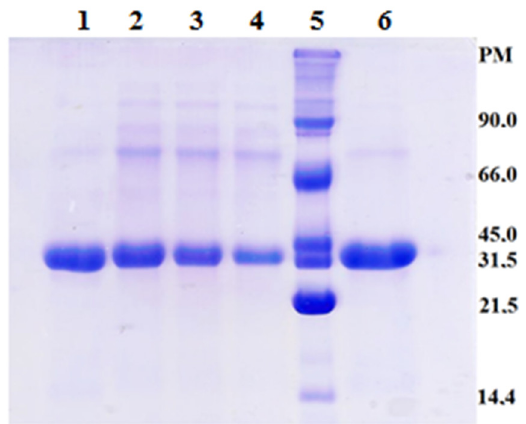
Figure 4. SDS-PAGE analysis of the starting solution of CALB and during adsorption on Ns SiO 2 . Line 1: 10 µ L, starting solution at time 0 min of contact; Line 2: 10 µ L, 5 min of contact with the support; Line 3: 10 µ L, 10 min.; Line 4: 10 µ L, 60 min.; Line 5: 4 µ L, molecular weight patterns; and Line 6: 15 µ L, starting solution at time 0 min.